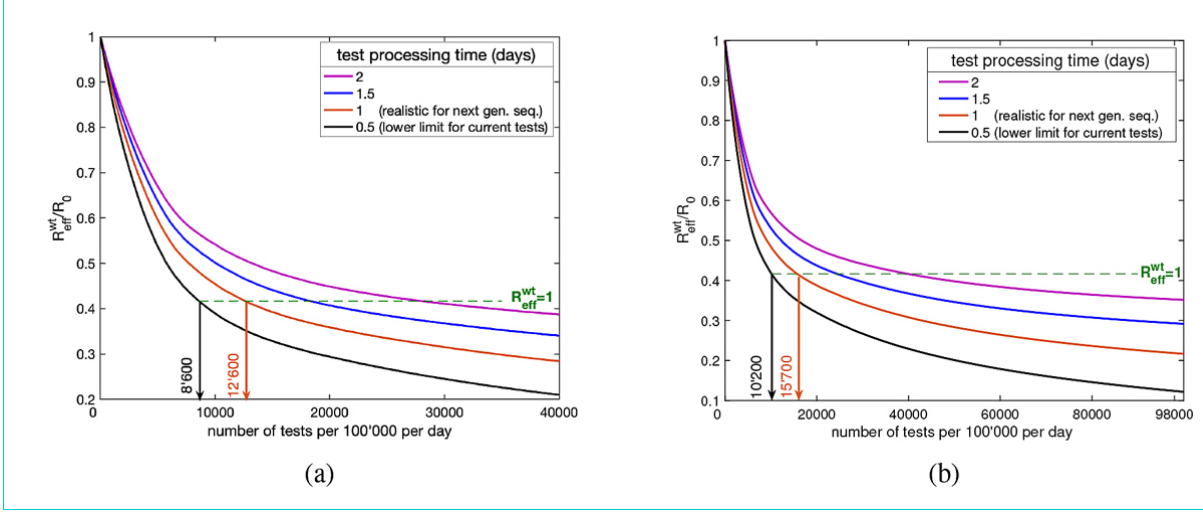
depends on the time from sampling to result. A mitigation Figure 4: Mass testing. The number of tests required to reach strategy relying on mass testing alone is assumed and we computed the number of tests performed per day, which are needed to ℛ eff = 1 achieve a particular test-speed dependent ratio; for (a) and (b) false negative test results are assumed. The . Test speeds were: 0.5 days (black line), 1 day (orange line), 1.5 days (blue line) and 2 days (purple green lines indicate eff𝑤𝑤𝑢𝑢 ℛ / ℛ 0 5% 15% eff𝑤𝑤𝑢𝑢 ℛ = 1